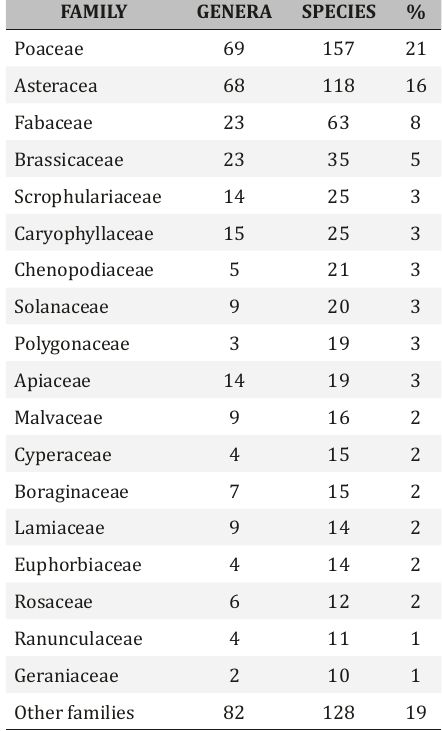
List of families with number of genera, species and percent over total alien flora in